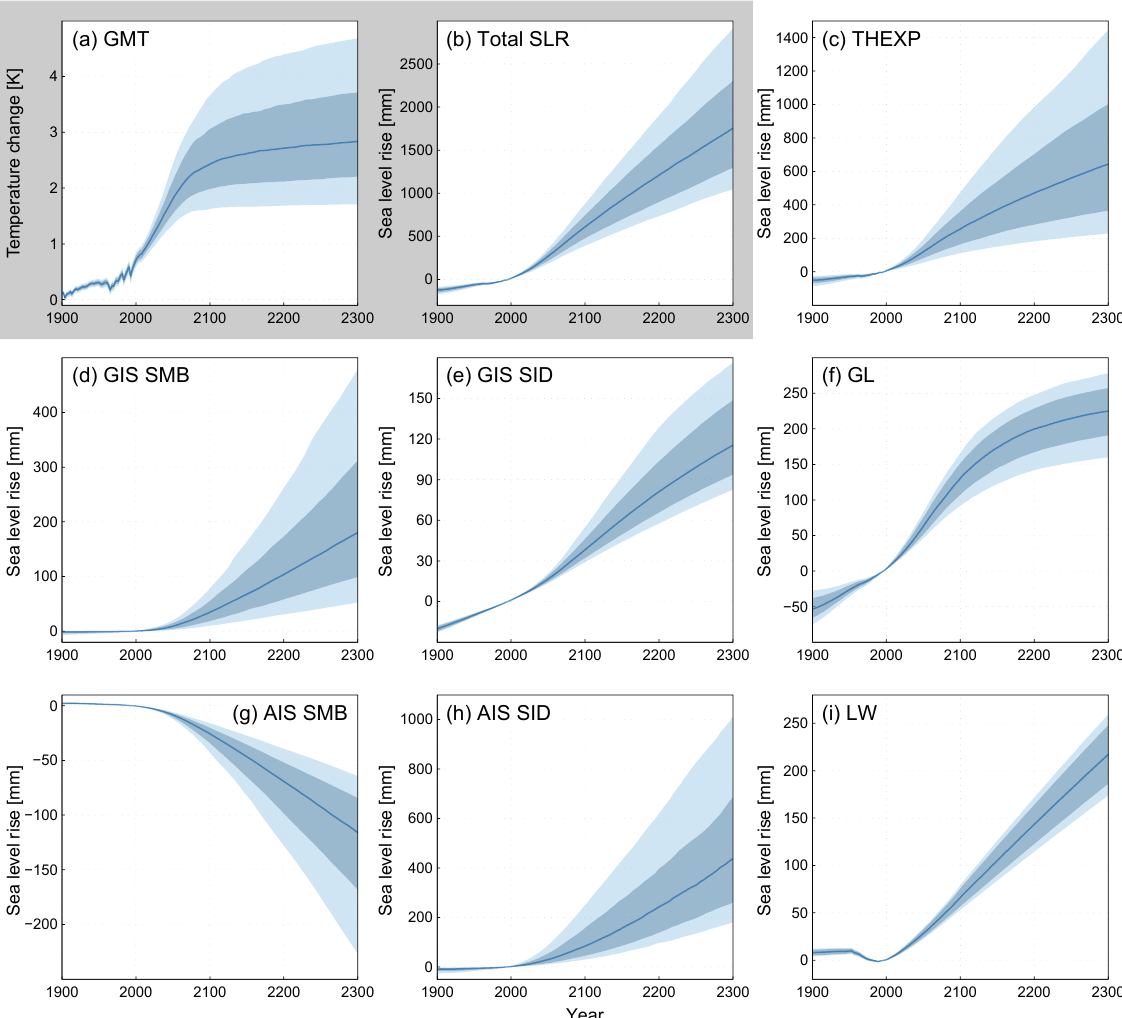
Figure A5. The 1900–2300 SLR projections resolved by the individual MAGICC sea level components for RCP4.5 in millimeters. We show median estimates, 66% ranges in darker shading, and 90% ranges in lighter shading for MAGICC GMT output relative to pre-industrial in panel (a) , total SLR in panel (b) , thermal expansion (THEXP) in panel (c) , Greenland ice-sheet (GIS) SMB and SID in panels (d) and (e) , global glacier (GL) in panel (f) , Antarctic ice sheet (AIS) SMB and SID in panels (g) and (h) , and land water LW in panel (i) . All sea level contributions are provided relative to